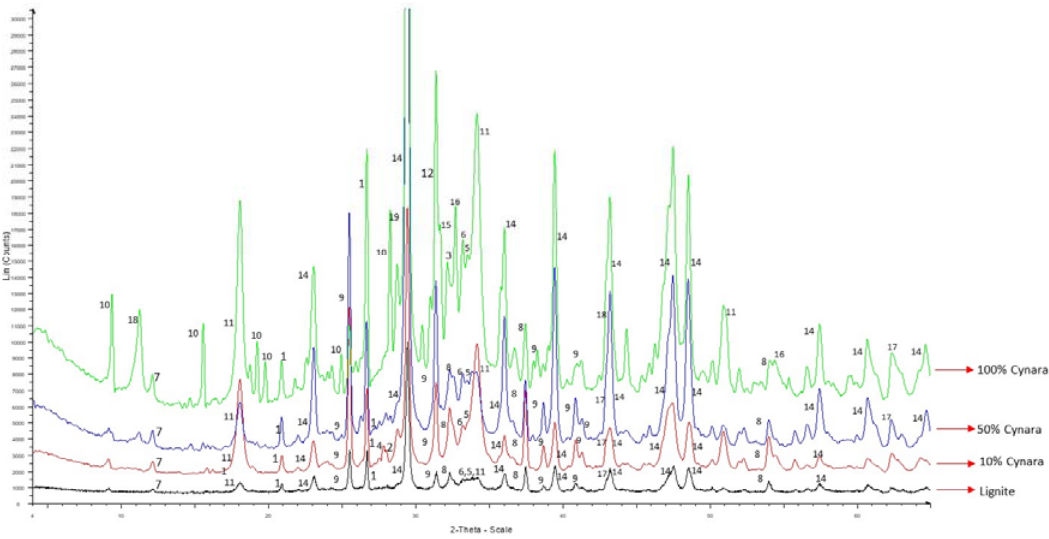
Figure 18. Comparison of X-ray powder diffraction scans of the fly ashes; numbers correspond to mineral phases in Table 7. Table 7. X-ray powder diffraction analyses of the fly ashes from experimental tests.